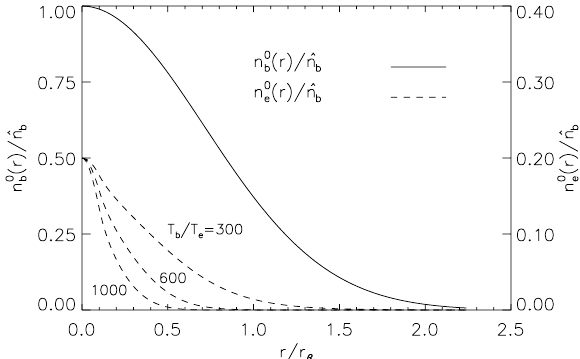
FIG. 2. The area to the right of the solid curve is the figure.